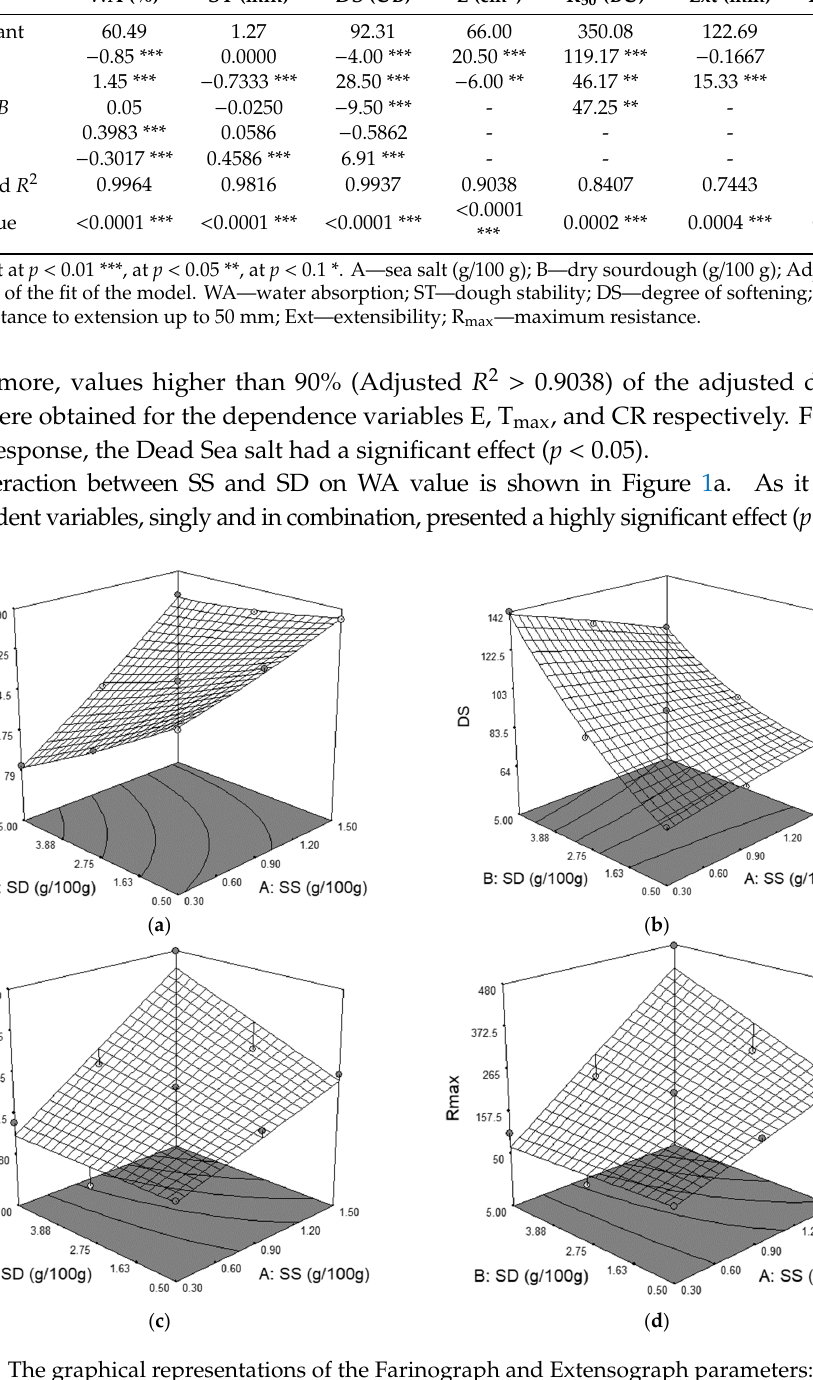
Table 2. Effects of formulation factors expressed as their corresponding coefficients on the predictive models for dough rheological properties during mixing of sea salt–dry sourdough mixtures. Factors